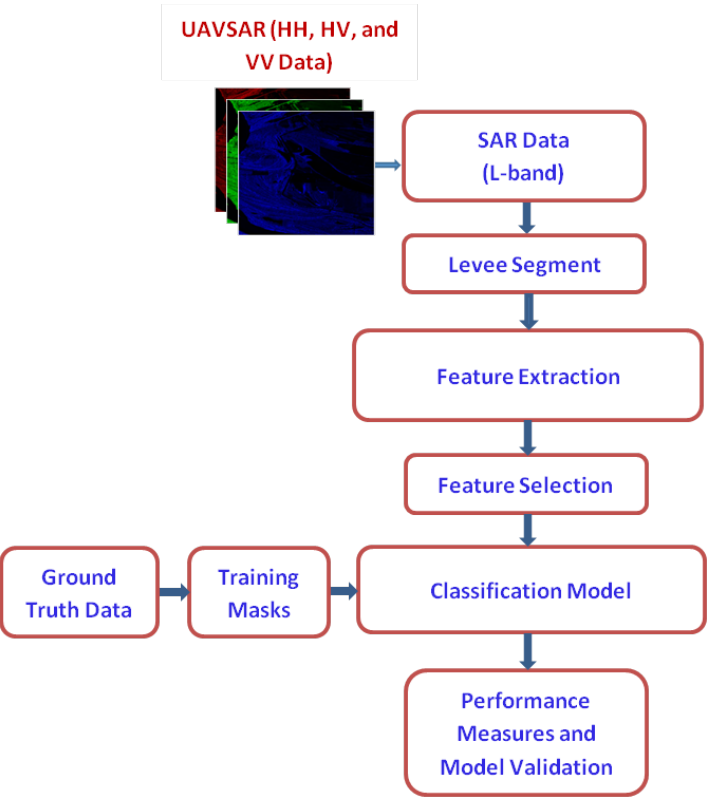
Figure 1. Block diagram of UAVSAR image processing